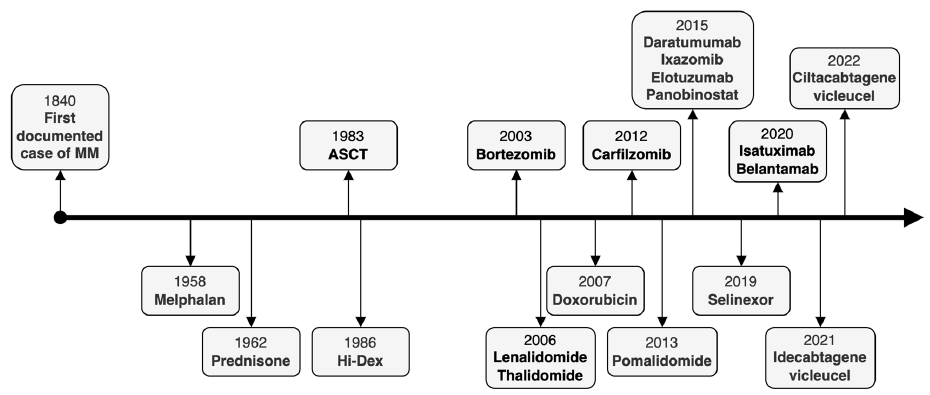
Figure 2. Timeline of treatment advancements in multiple myeloma.